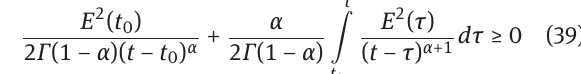
Fig. 11: Chaos suppression in PMSG ( t = 140